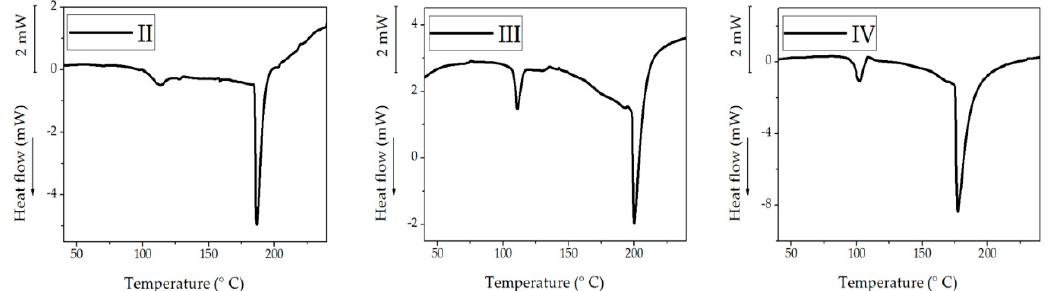
Figure 9. Thermograms for DM obtained from four different protocols.